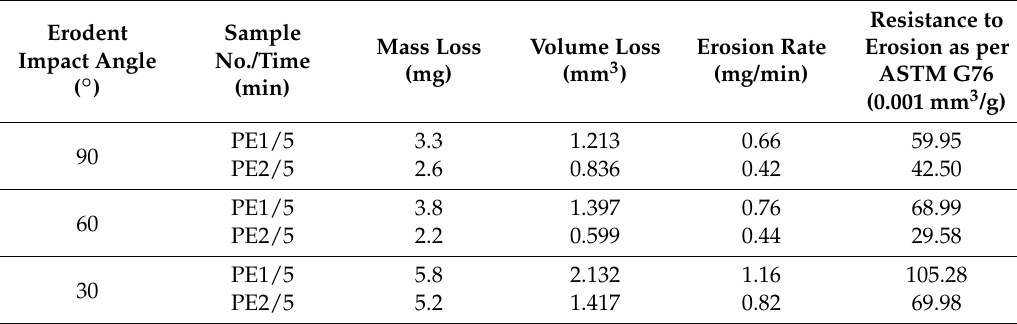
Table 3. Summary of results obtained during the erosion test.